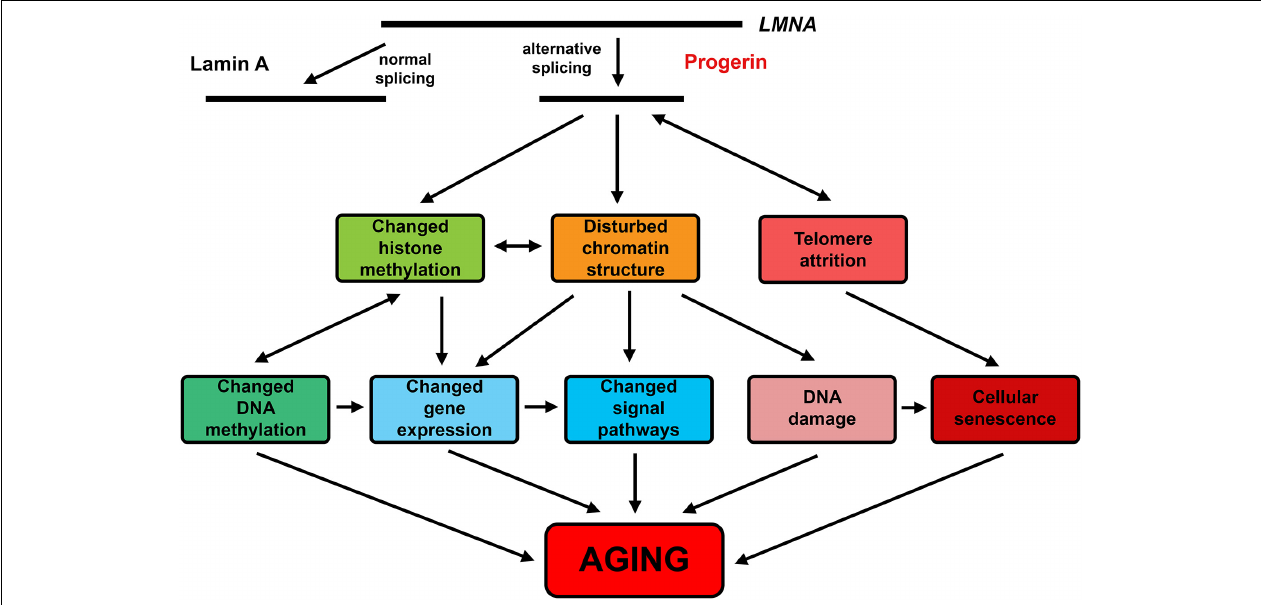
FIGURE 2 | The effects of progerin common in HGPS and natural